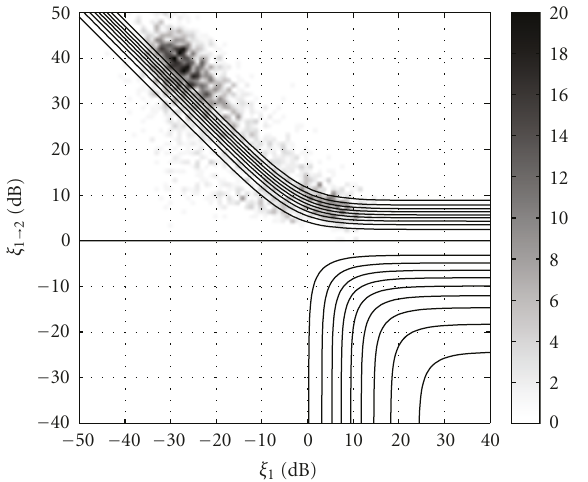
Figure 13: Detected occurrences of phoneme “t” ( λ = 0 .